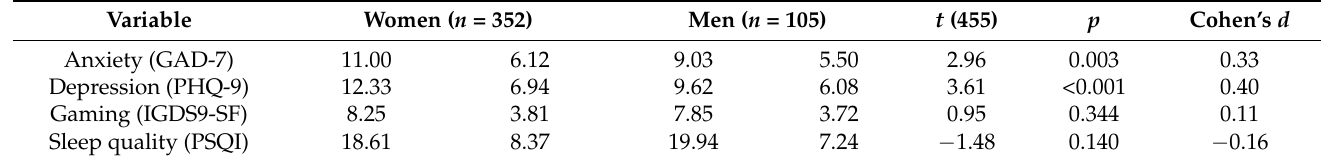
Table 3. Student’s t -test for gender differences.